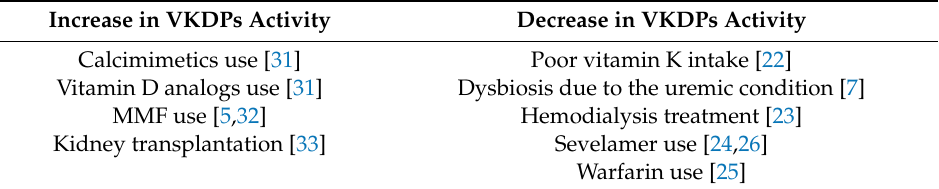
Table 2. Factors a ff ecting vitamin K status in chronic kidney disease (CKD)